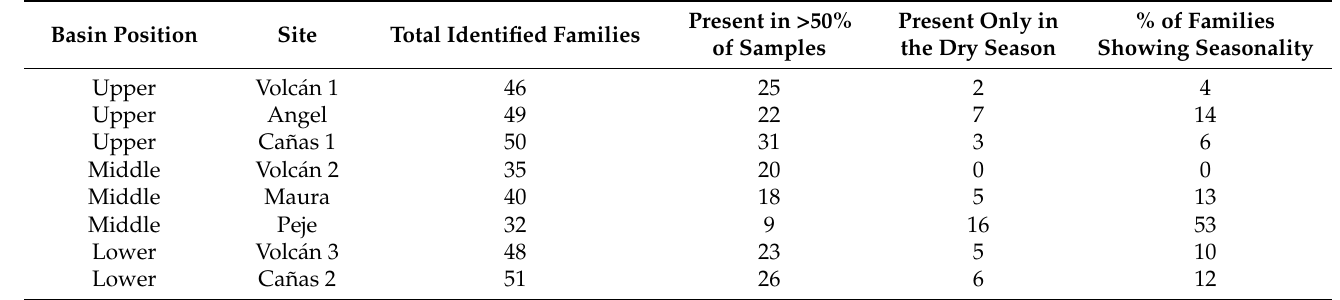
Table 2. Summary of benthic macroinvertebrate families and seasonality pattern in the sampling sites, period 2011–2013. Number of total identified macroinvertebrate families per site and seasonality pattern of registered families.